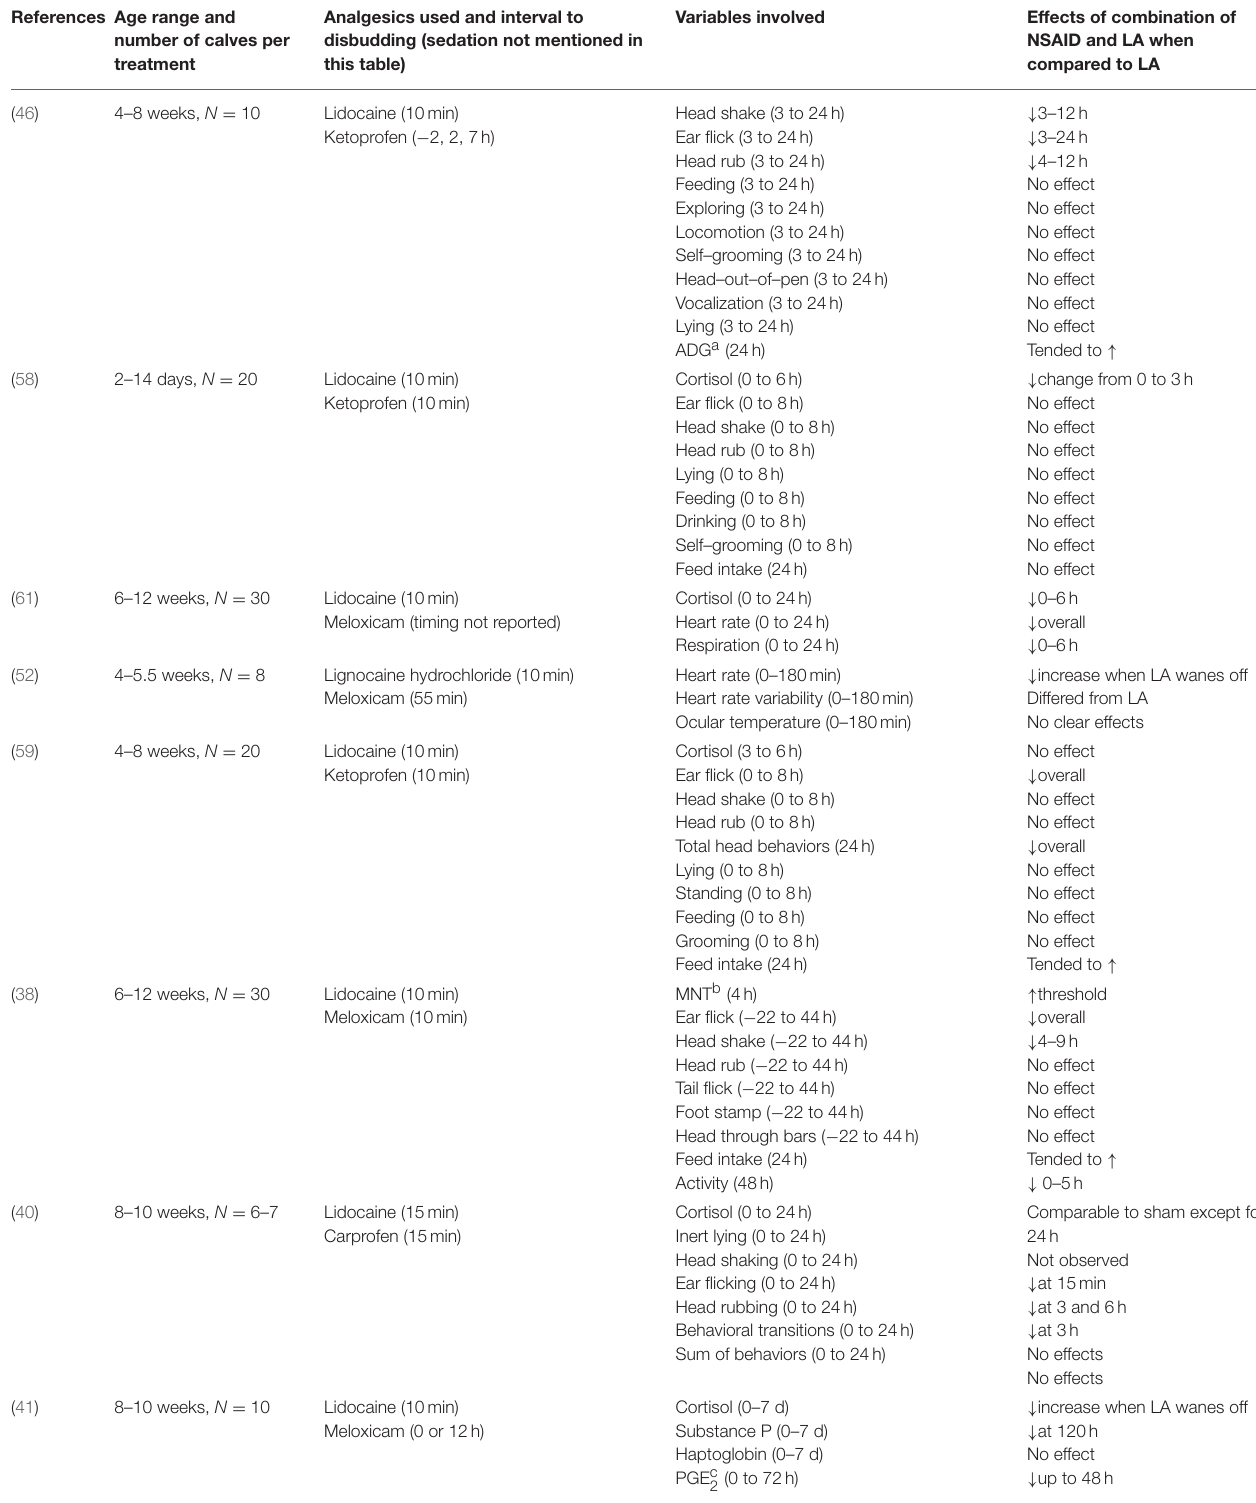
Variables involved Effects of combination of